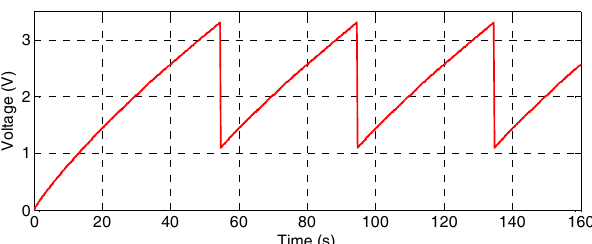
Figure 5. Voltage evolution on the capacitor C res during charging and communication processes, with the VEH working at 10 Hz, 2 g peak with an external bias of 20